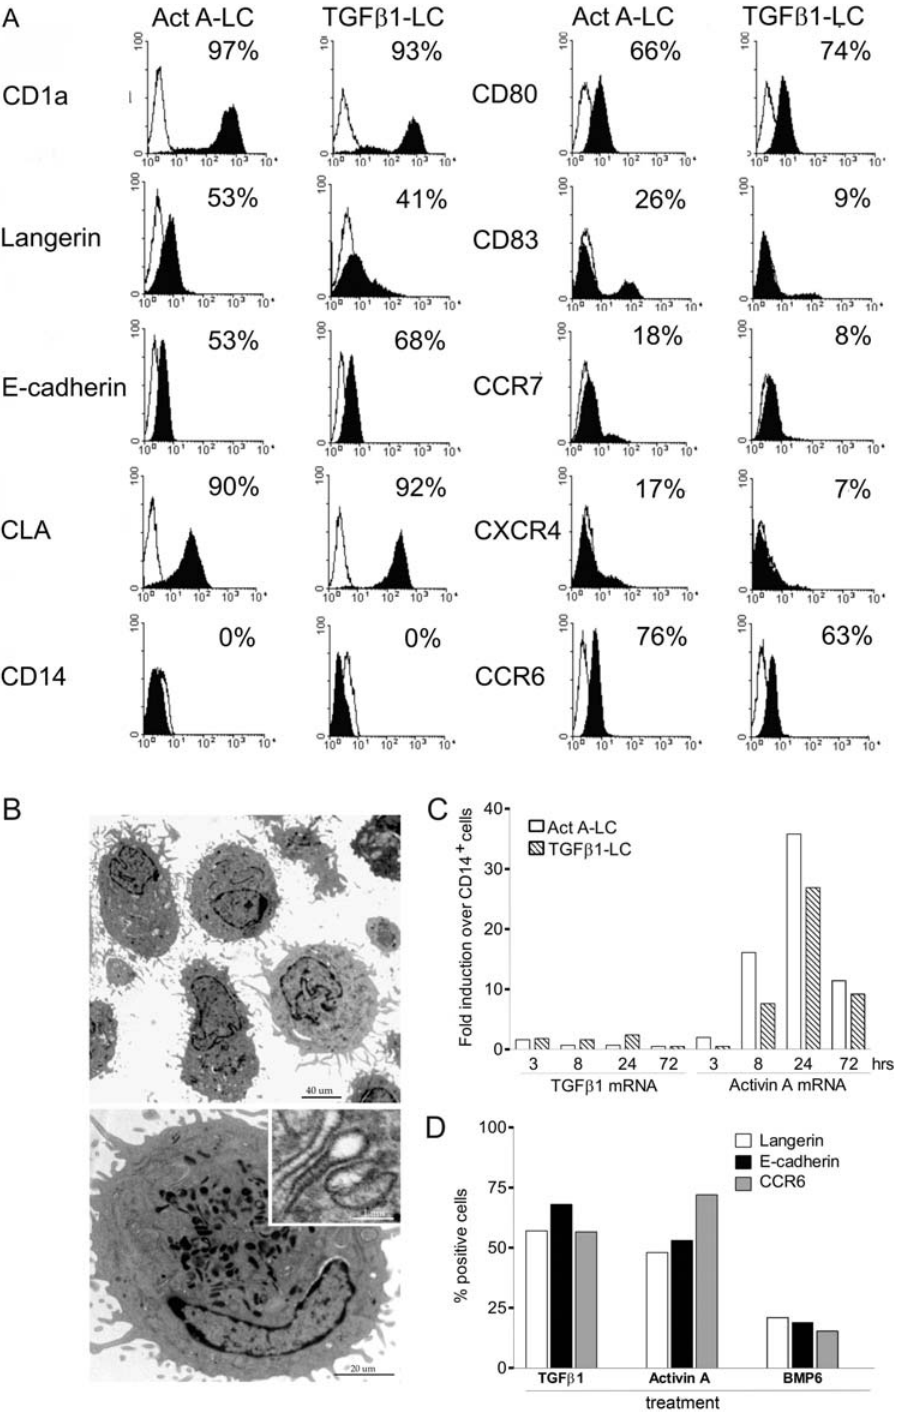
Figure 1. Activin A promotes Langerhans cell differentiation from human CD14 + monocytes. (A) Phenotypic analysis of monocytes cultured for 6 days with GM-CSF and IL-4 in the presence of Activin A (Act A-LC) or TGF b 1 (TGF b 1-LC). Cells were stained with the indicated moAbs (filled histograms) or isotype-matched negative control moAbs (open histograms). Percentages of positive cells are shown in the upper right corner of each histogram. The figure shows one experiment representative of at least five independent cultures. (B) Electron microscopy analysis of Act A- LC. Act A-LC exhibited abundant dendritic membrane protrusions and lobulated or indented nuclei (left panel, 3,000X, bar 40 m m). Cytoplasm presented a rough endoplasmic reticulum, many multilamellar organelles and numerous electron-dense structures reminiscent of Birbeck granules (right panel, 12,000X, bar 1 m m). The inset shows rod-shaped Birbeck granules (200,000X, bar 20 m m). (C) TGF b 1 and Activin A mRNA expression in Act A-LC and TGF b 1-LC cultures. Monocytes were cultured in the presence of Act A or TGF b 1 for the indicated time and the expression of TGF b 1 and Activin A mRNA was determined by real-time PCR, relative to GAPDH mRNA used as internal control. The expression level in freshly isolated monocytes was assumed as the 1.0 value. Similar results were obtained in three different donors. (D) Effects of different TGF family members on LC differentiation. Monocytes were cultured for 6 days with GM-CSF in the presence of 10 ng/ml TGF b 1, 100 ng/ml Activin A, or 100 ng/ml BMP6 and analyzed for Langerin, E-caderin and CCR6 expression by flow cytometry analysis. Data are representative of at least four independent cultures.